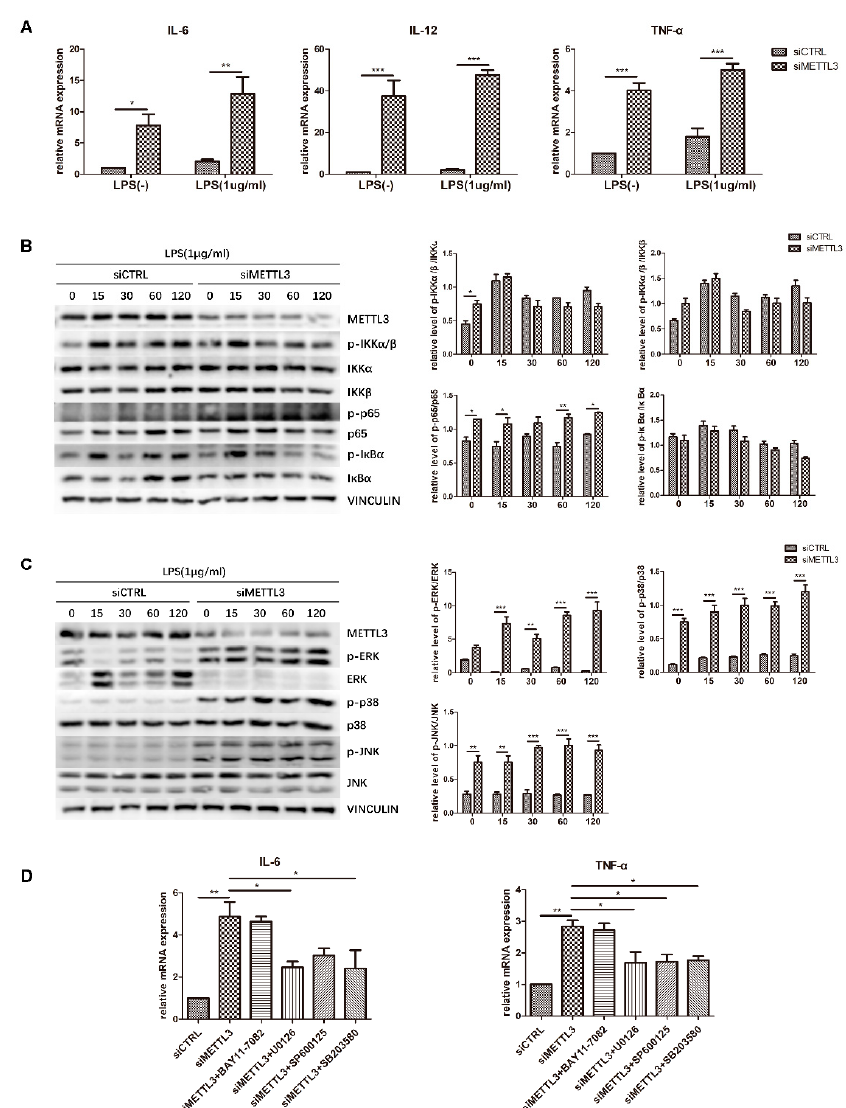
Figure 5. E ff ect of METTL3 knockdown on osteoblast proinflammatory cytokine production and MAPK and NF- κ B signaling activation. ( A ) MC3T3-E1 cells were transfected with siRNA (METTL3 or negative control) and then cultured in osteogenic medium with or without 1 µ g / mL LPS for 60 h. The expression of IL-6 , IL-12 , and TNF- α was examined by qRT-PCR. Gapdh was used as an internal control. ( B , C ) Cells transfected with siRNA (METTL3 or negative control) were cultured in osteogenic medium for 60 h and then treated with 1 µ g / mL LPS for 0–120 min. MAPK and NF- κ B phosphorylation was examined by western blotting, and VINCULIN was used as an internal reference. ( D ) Cells transfected with siRNA (METTL3 or negative control) were treated with the NF- κ B inhibitor BAY 11-7082, the p38 inhibitor SB203580, the ERK inhibitor U0126, or the JNK inhibitor SP600125 for 1 h and then cultured in LPS-induced osteogenic medium for 60 h. The mRNA levels of IL-6 and TNF- α were detected by qRT-PCR. Gapdh was used as an internal control. The results are shown as the mean ± SD ( n = 3). * p < 0.05, ** p < 0.01, *** p < 0.001.